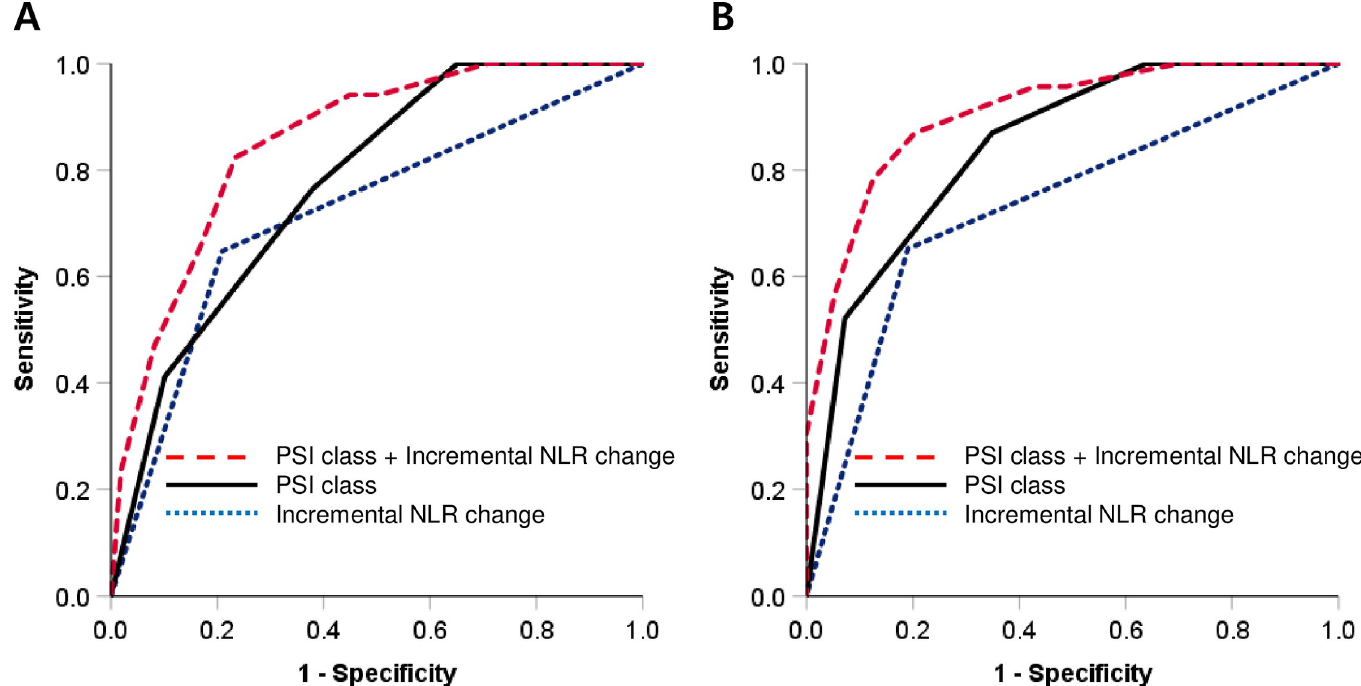
Fig 4. Receiver operating characteristic curve analyses of the ability of incremental NLR change (NLR D4/D1 > 1) and the pneumonia severity index class to predict 30-day mortality (A) and intensive care unit admission (B) in hospitalized patients with community-acquired pneumonia. The area under the curves significantly increased when incremental NLR change was added to the PSI